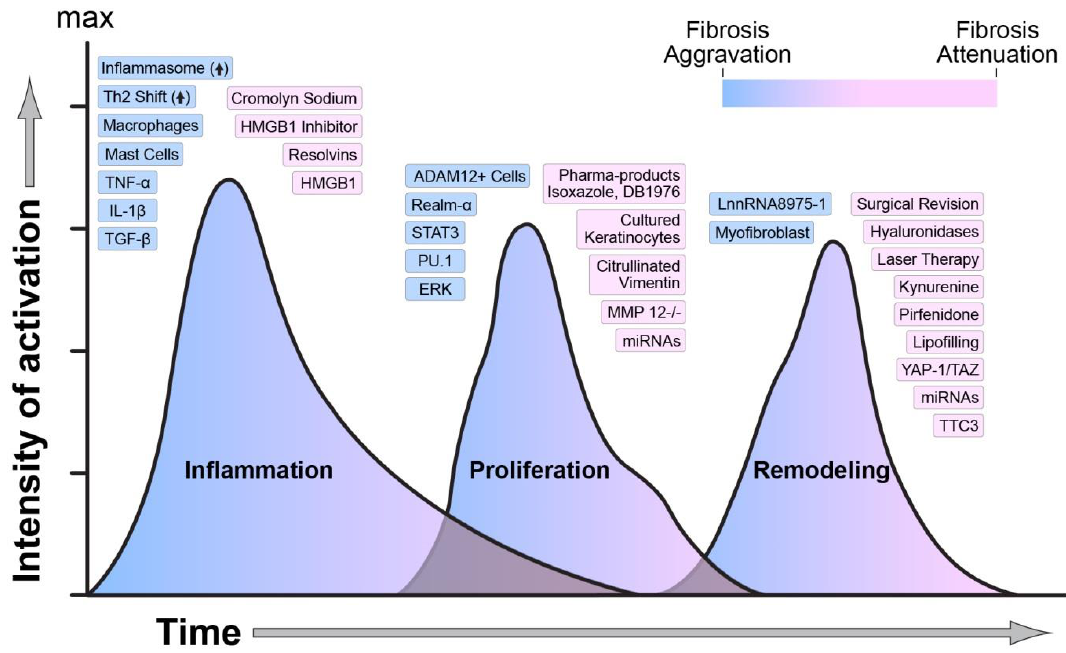
Figure 1. Regulators of wound healing and scarring. The temporal activation, overlap, and intensity of activation of each phase of wound healing are regulated by numerous molecular, biological, and mechanical factors. The figure indicates how each one of these factors is modulating wound healing towards an aggravation or an attenuation of fibrosis. Blue indicates activation, and pink indicates attenuation of fibrosis.